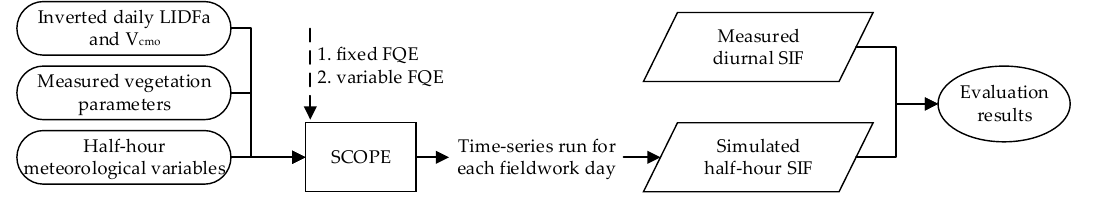
Figure 4. Schematic overview of SIF simulations and model evaluation.